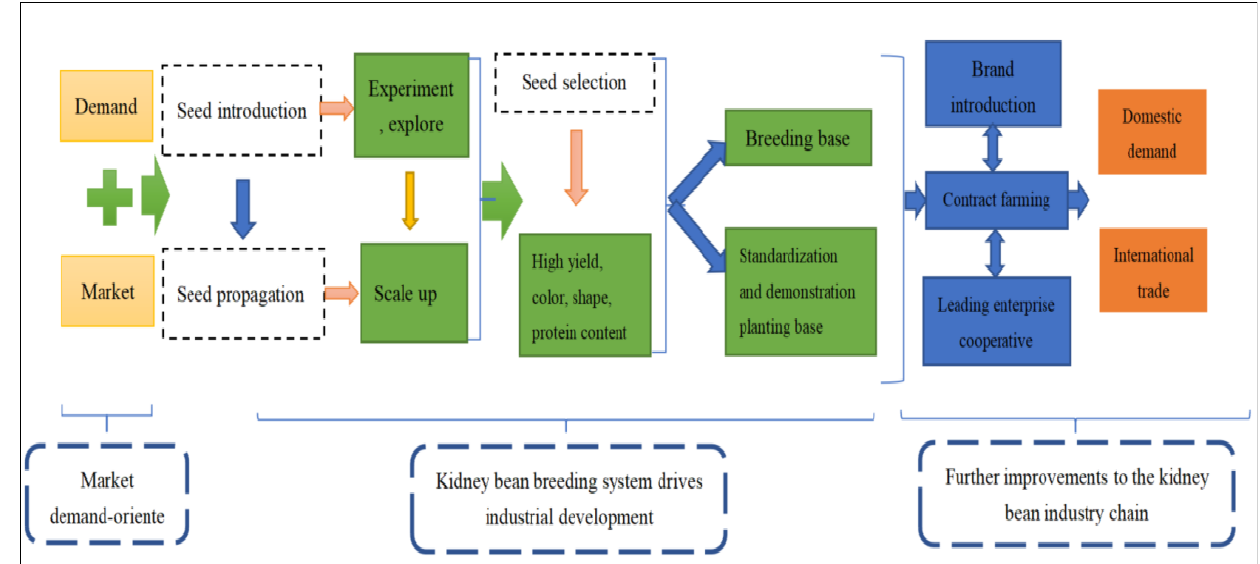
Figure 2. Mechanism of the kidney beans’ industrial development.